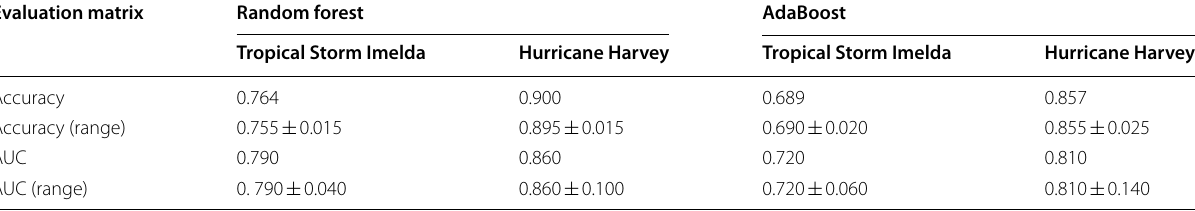
Table 2 Results of evaluation matrix for the model performances Evaluation